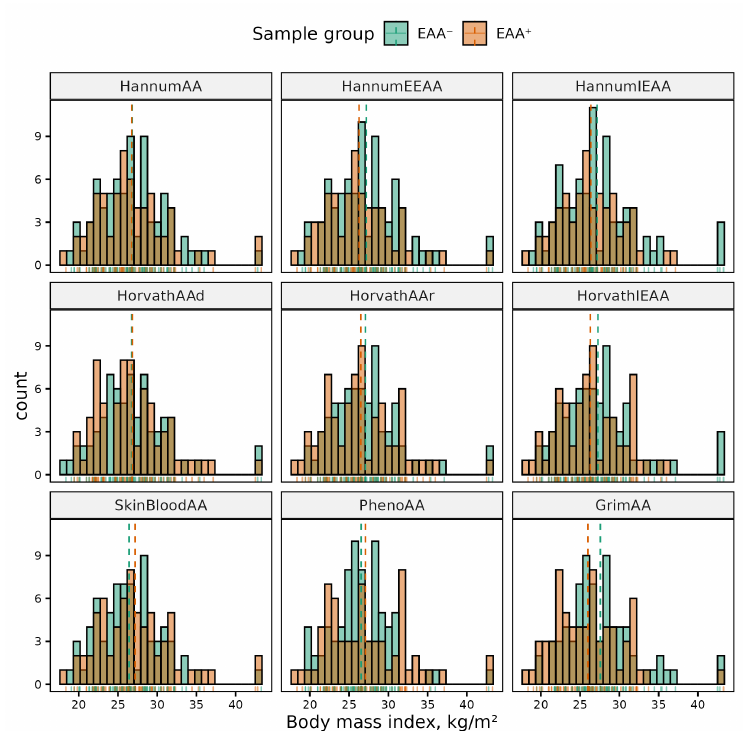
Figure A5. Histograms of distributions of BMI in males in EAA + and EAA − groups. Dashed lines correspond to the group means.